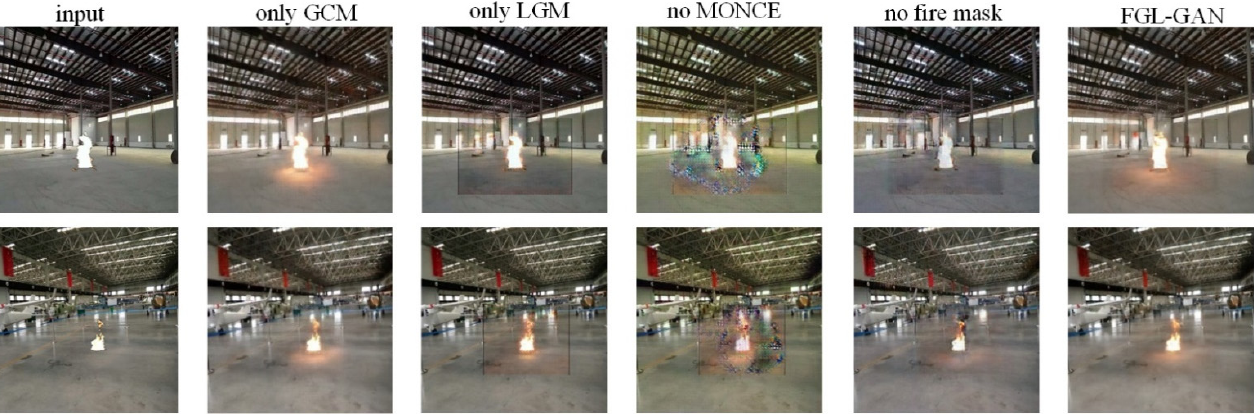
Figure 11. Ablation study of prediction sets.